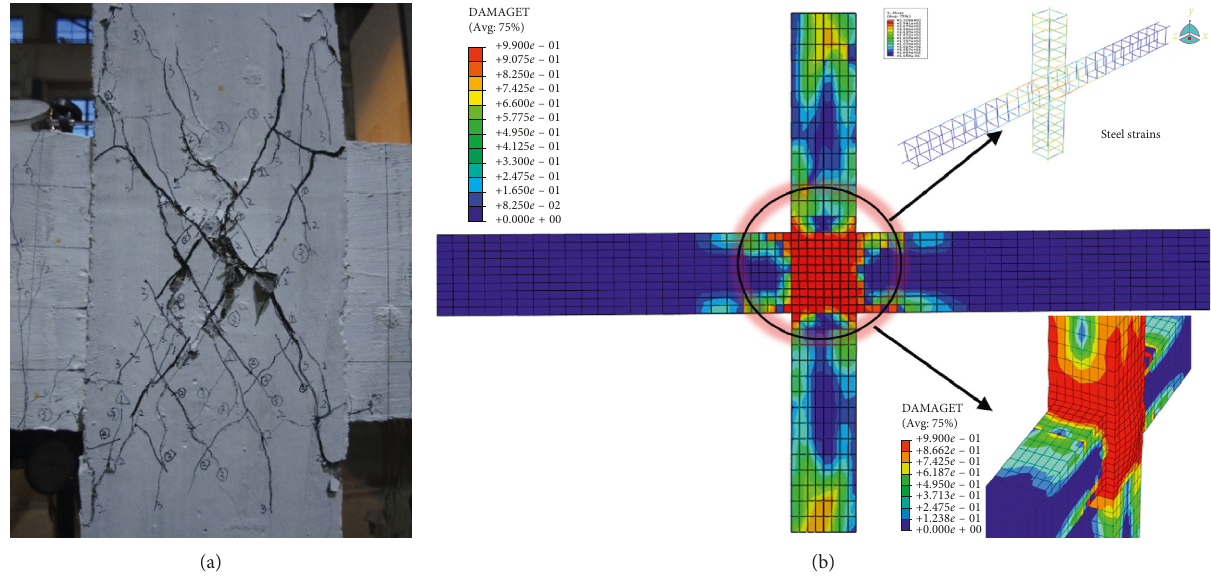
Figure 30: Model results of failure mode of HFRC beam-column joints. (a) Experimental observation. (b) Crack